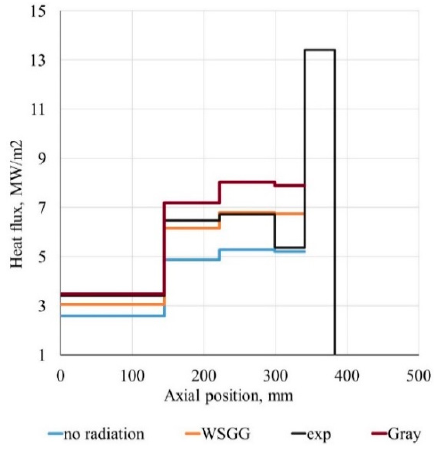
Figure 9. Absolute pressure axial distribution.